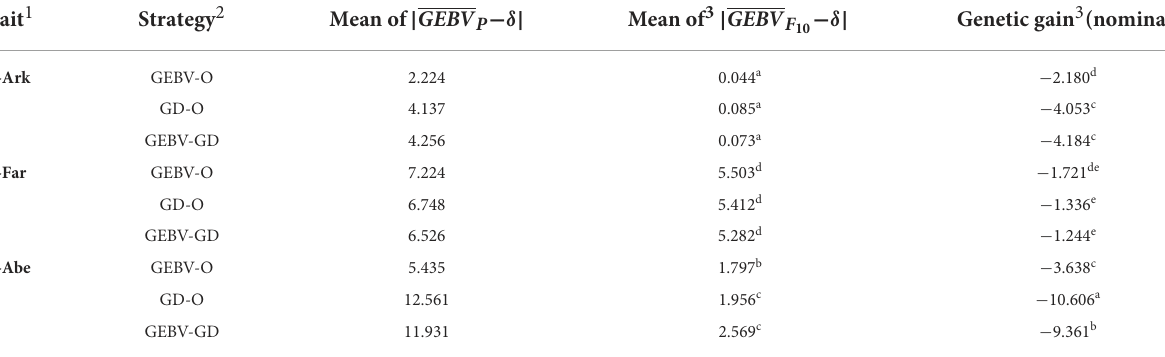
TABLE 4 GEBV average for parental lines, GEBV average for F 10 inbred lines, and genetic gain for the 44k rice dataset based on the index weights of 1/3, 1/3, and 1/3. Trait